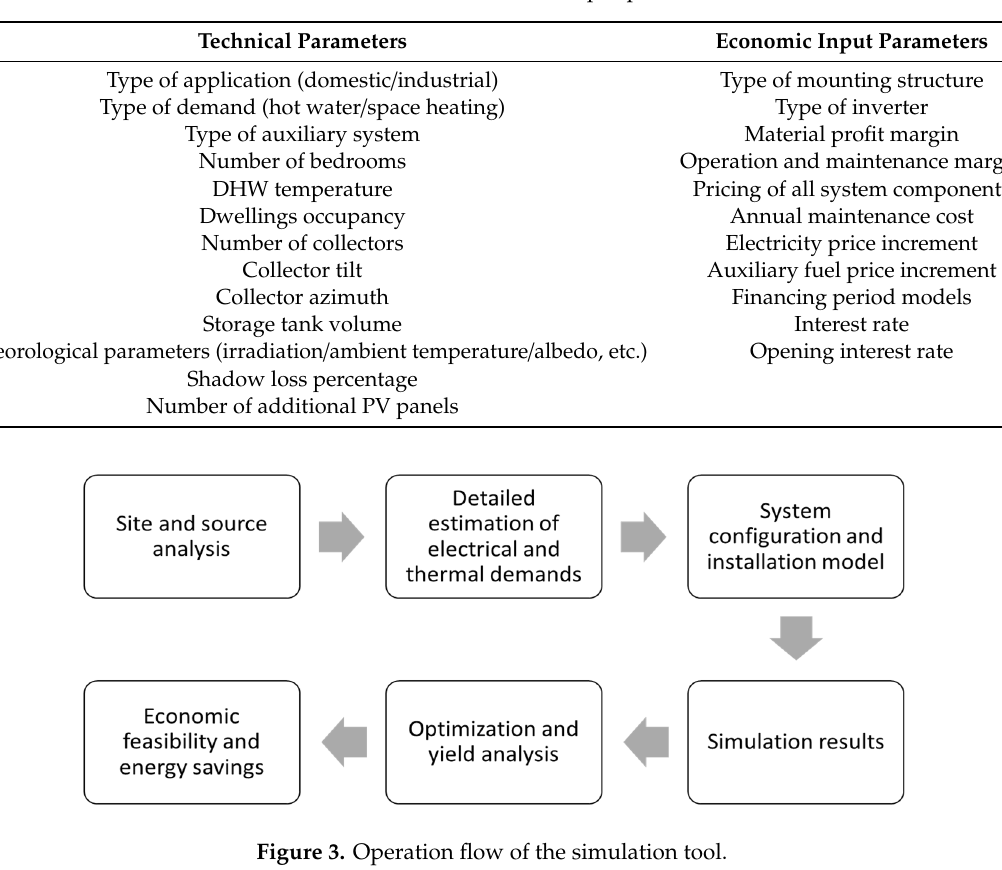
Table 2. Technical and economic input parameters.